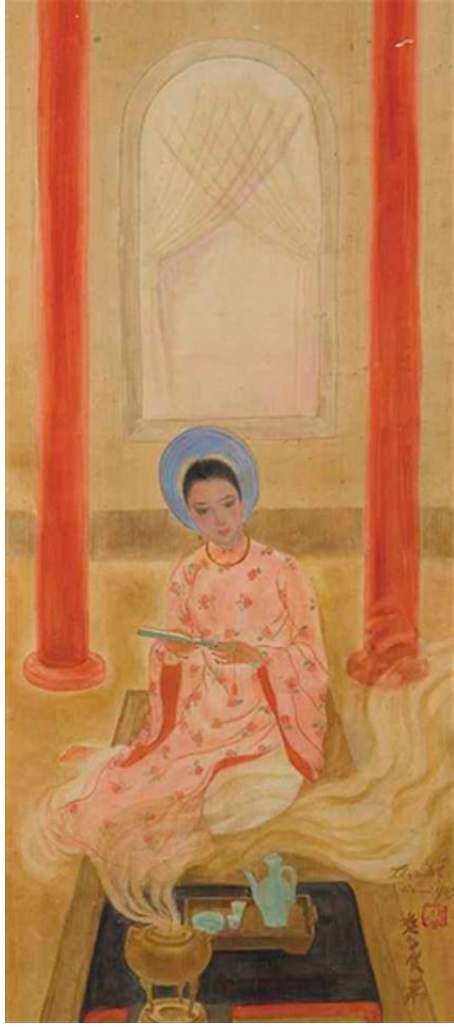
Figure A7. Lady of Hue —Le Van De. The image was sourced from Thanh Nien Newspaper (An 2016).